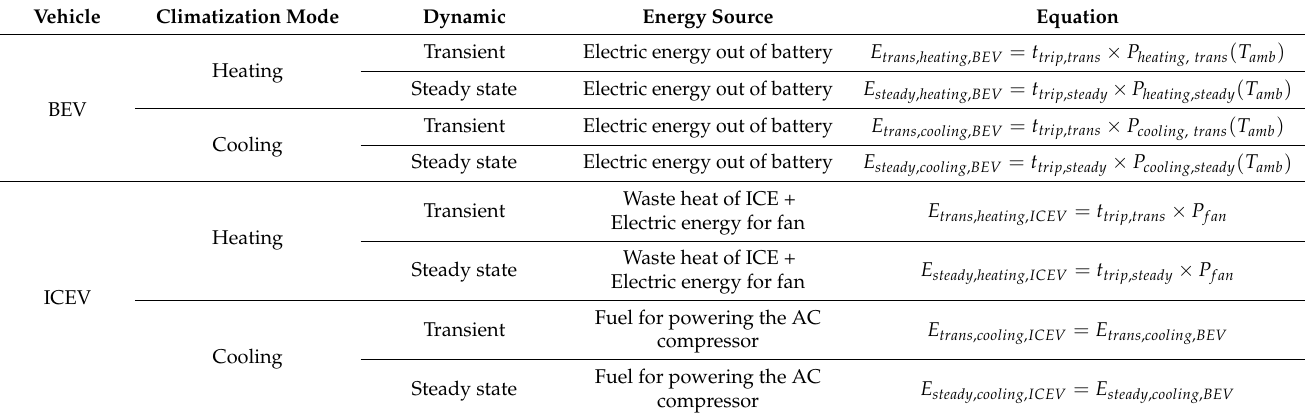
Table 2. Calculation of climatization energy for different drivetrains, climatization modes and dy-